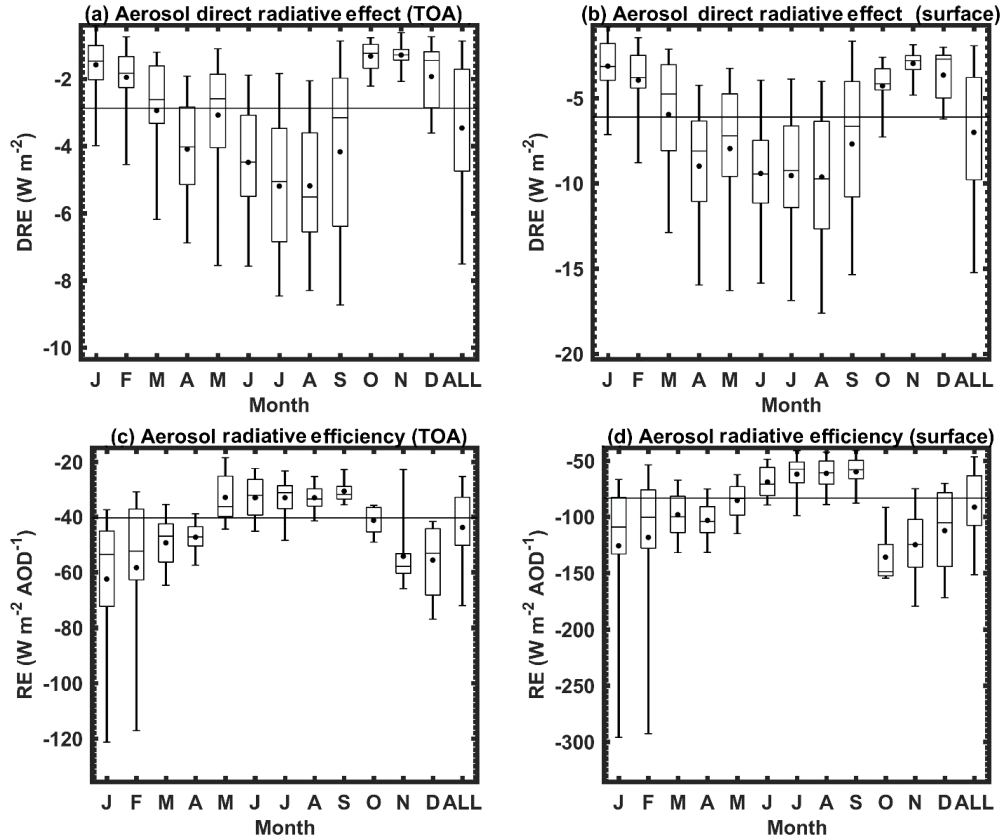
Figure 4. Boxplots of calculated monthly binned aerosol DRE and RE at the top of atmosphere and the surface. The “ALL” box provides the statistics for all days in June 2012 to February 2016 period. The mean for each month is denoted by the dot while the horizontal bar represents the median. The top and bottom of the box represent 75th and 25th percentiles while the top and bottom whisker extend to the 95th and 5th percentiles, respectively. The horizontal line drawn through all boxes of each plot represents the median value over the entire period (all